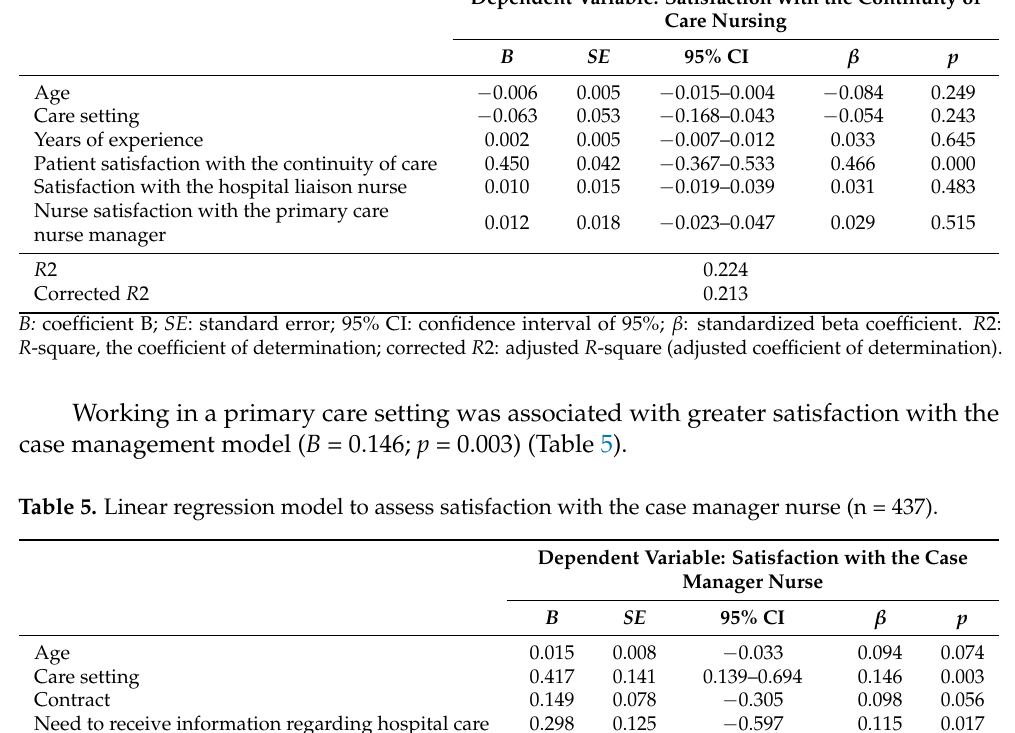
Table 4. Linear regression model to assess satisfaction with continuity of care nursing (n = 437). Dependent Variable: Satisfaction with the Continuity of Care Nursing